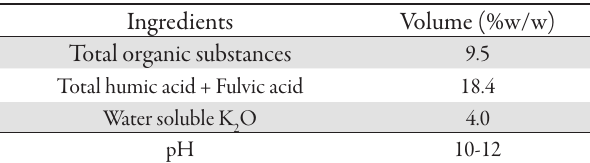
Tab. 1. The ingredients of humic acid solutions